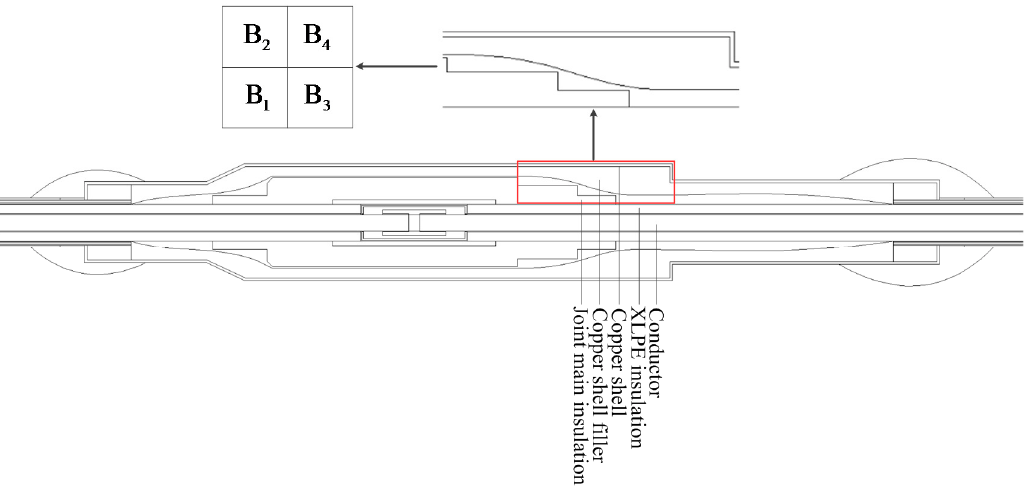
Figure 10. Partially enlarged region B in Figure 7.